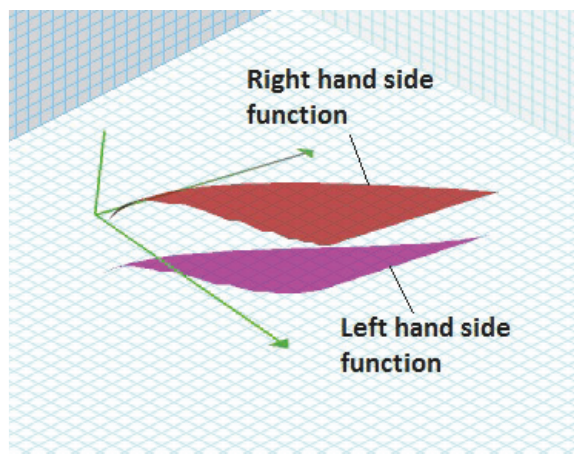
Figure 1: Right hand side superimposes left hand side in Case 1